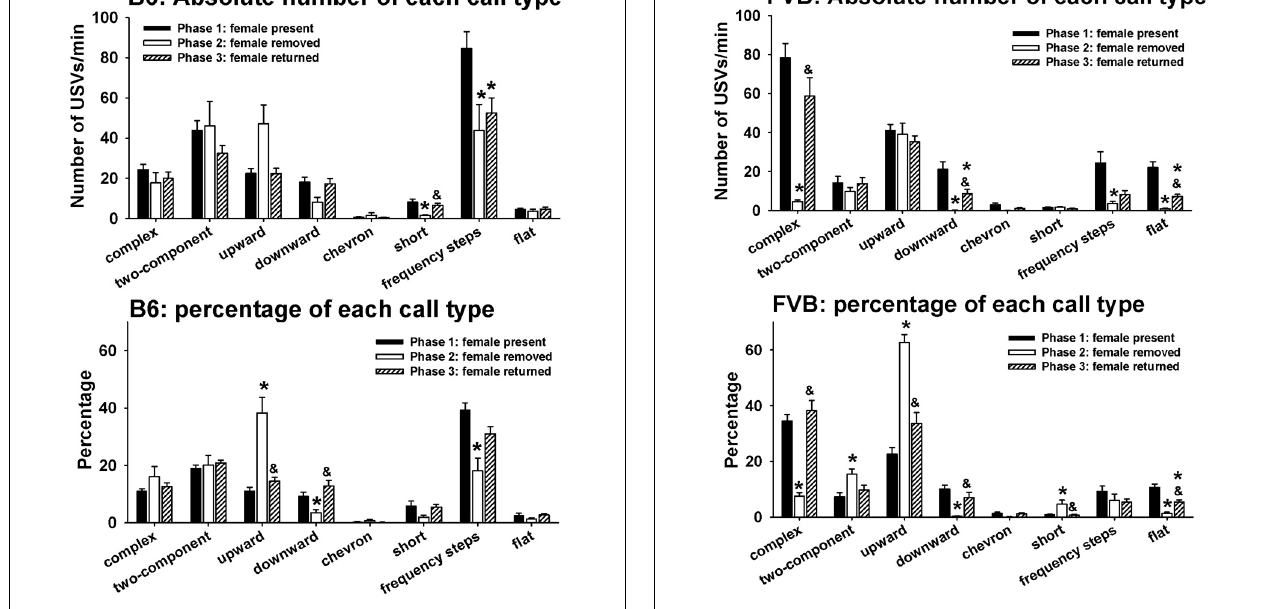
FIGURE 4 | Call repertoires in B6 males in phases 1, 2, and 3. USVs were detected from 12 out of 12 B6 in phase 1, 4 out of 12 B6 in phase 2, and 10 out of 10 B6 in phase 3. Only animals that emitted USVs were included in call category analysis. Analysis of absolute values of USV numbers indicated significant phase effects on short and frequency steps. Fewer short and frequency steps were detected in phase 2 than in phase 1. More short were detected in phase 3 than in phase 2. Analysis of percentages of call types indicated significant phase effects on upward, downward, and frequency steps. Compared to phase 1, the percentage of upward was higher and the percentages of downward and frequency steps were lower in phase 2. These changes were reverted in phase 3, when the female returned. * p < 0 . 05 vs. phase 1; & p < 0 . 05 vs. phase 2. p < 0 . 001], and flat [ H ( 2 ) = 61 . 96, p < 0 . 001]. Fewer complex,